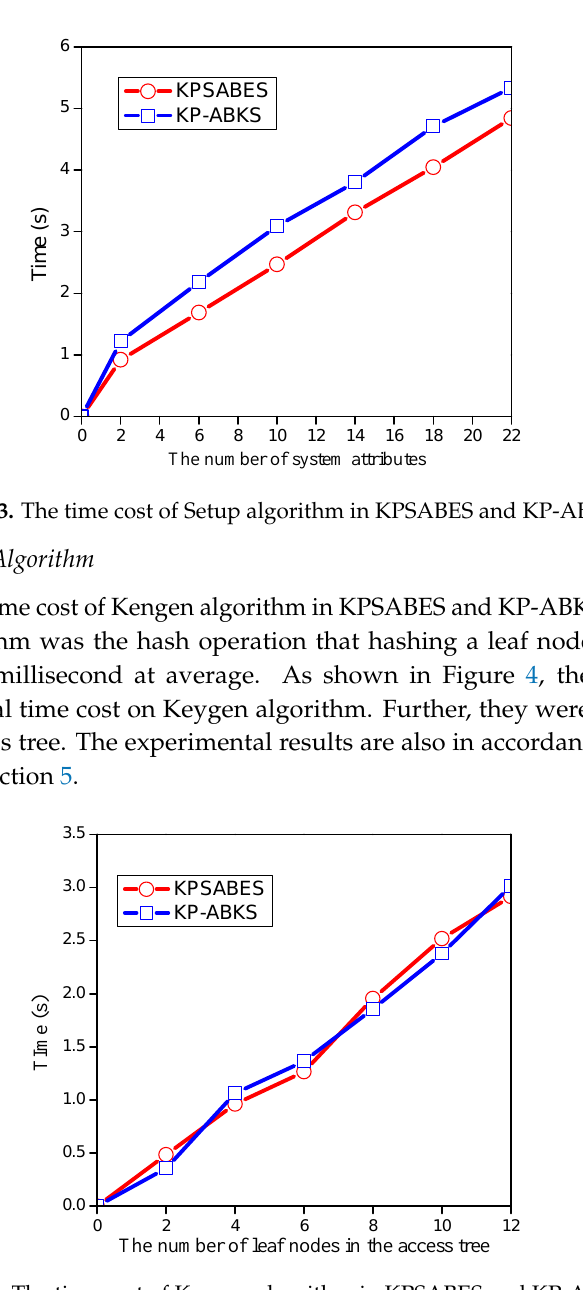
Figure 4. The time cost of Keygen algorithm in KPSABES and